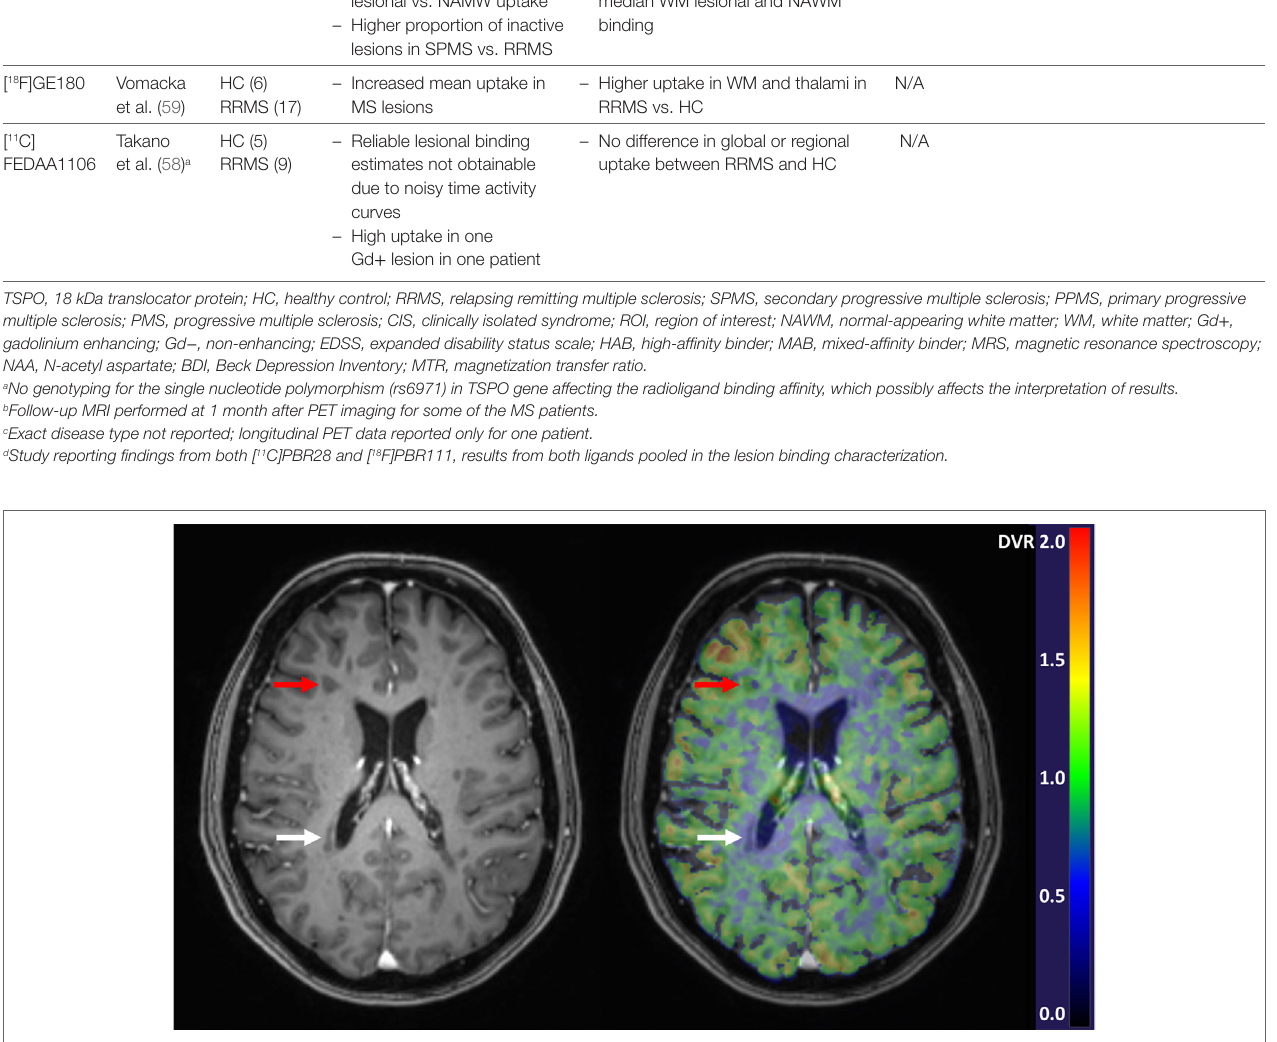
FiGURe 1 | Gadolinium enhanced 3DT1 MRI image (left) and parametric [ 11 C]PK11195-PET image overlayed with the 3DT1 image (right). Red arrows point to a chronic active T1-hypointense lesion with increased perilesional [ 11 C]PK11195 binding demonstrative of microglial activation, and white arrows point to a chronic inactive lesion with negligible radioligand binding. In the parametric PET image, the color of each voxel represents the intensity of specific radioligand binding measured as distribution volume ratio (DVR) and denoted by the scaled color